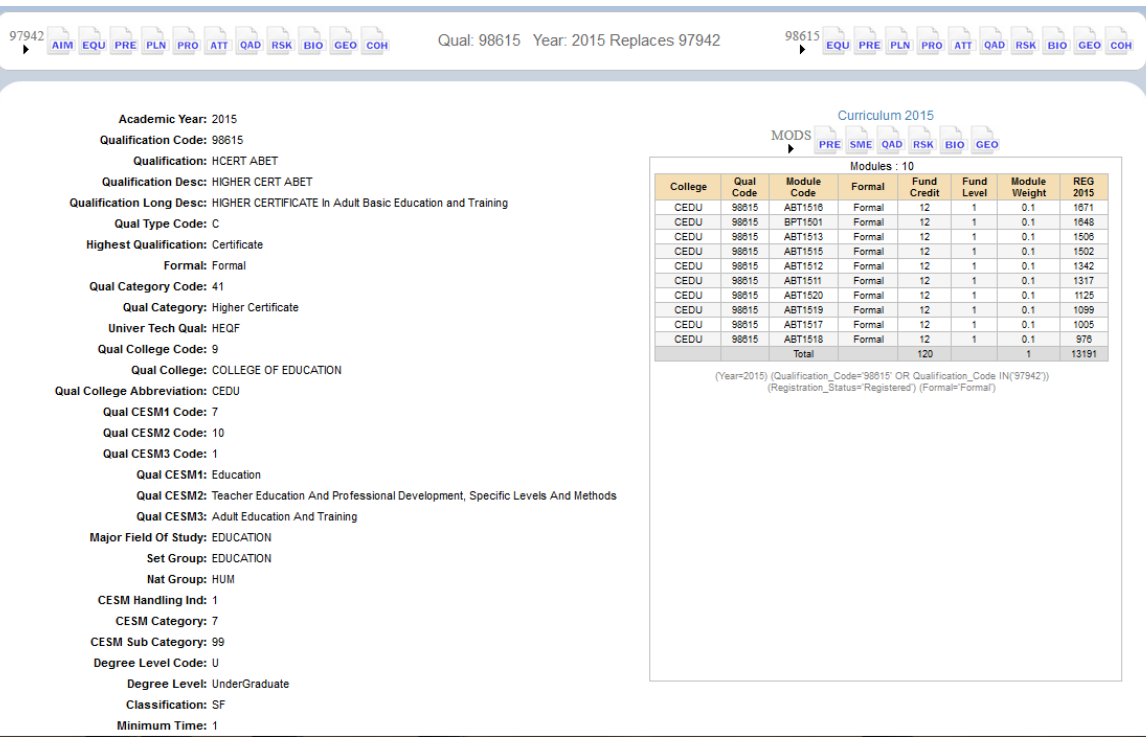
Figure 15. Example report with various navigation